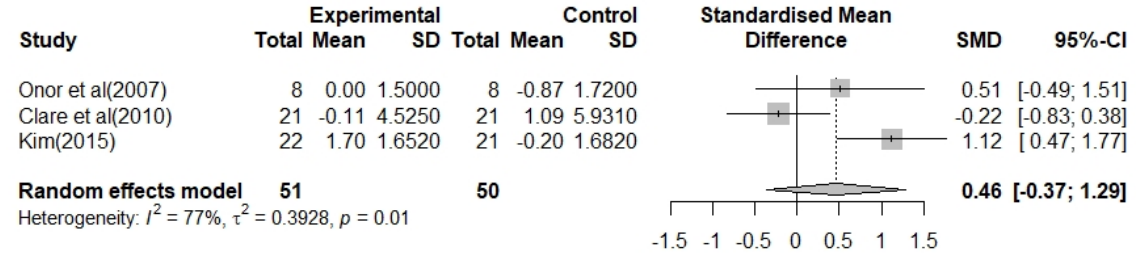
Figure 5. Forest plot for the effects of the multimodal occupational therapy program with cognition-oriented approach on IADL in patients with AD.